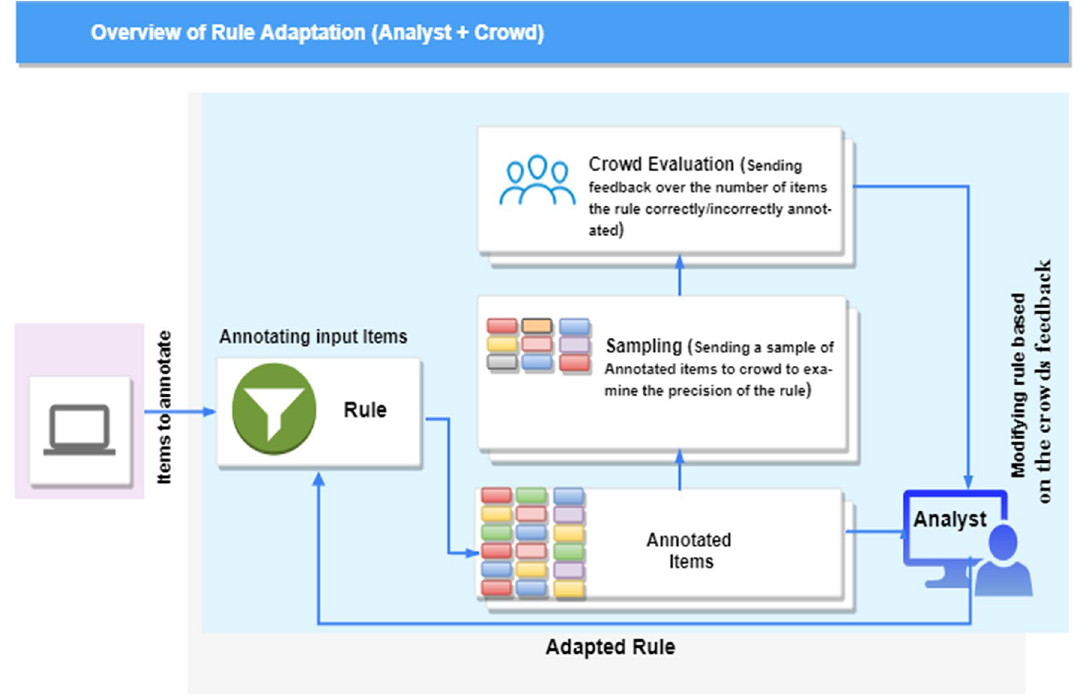
Fig. 1 The overview of adapting rules through analysts and crowd